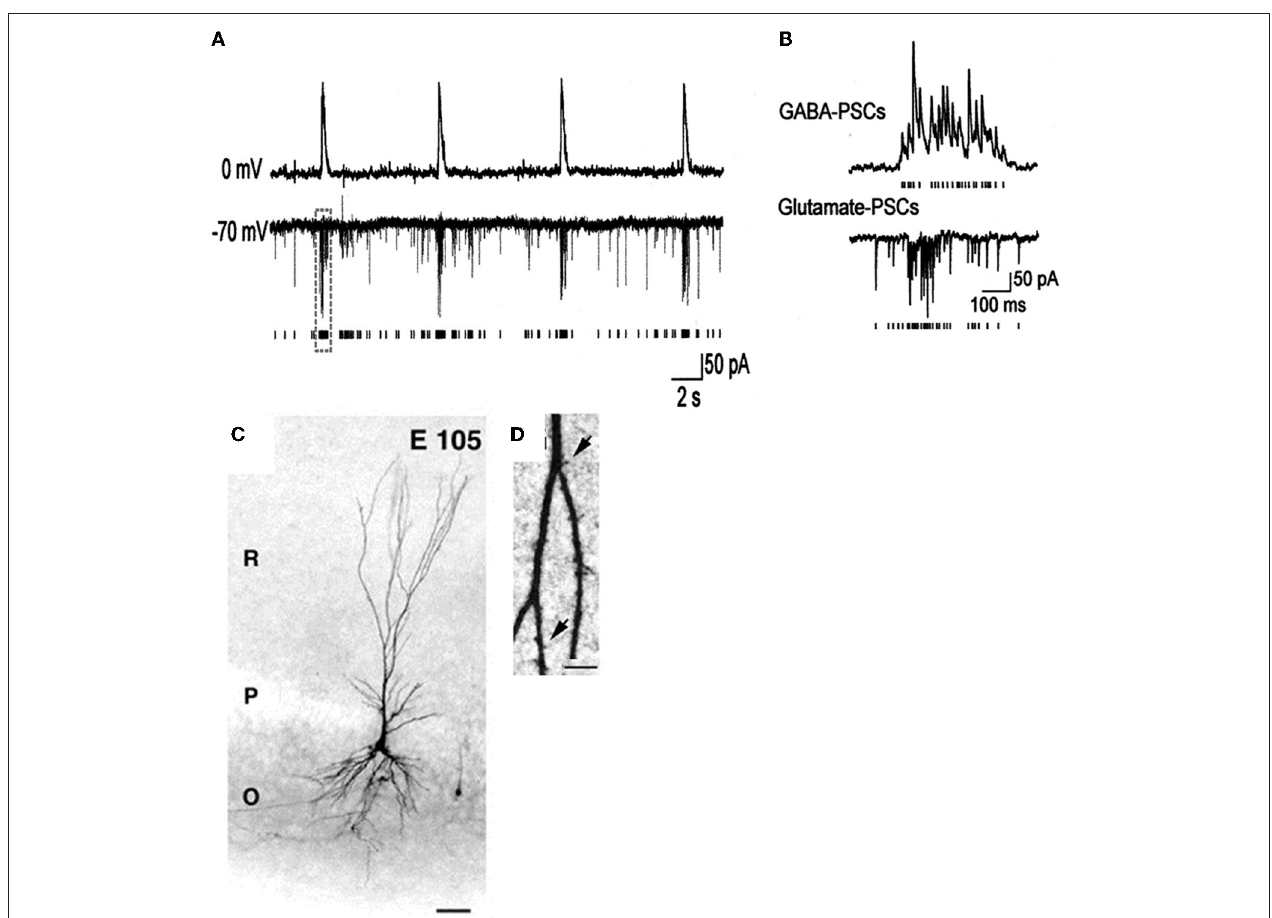
FIGURE 4 | Giant depolarizing potentials synchronize most of the Primate hippocampal neuronal activity in utero . (A,B) Pair recordings of CA3 pyramidal cells and interneurons (E109). (A) The pyramidal cell (top trace) is recorded in whole-cell mode at 0mV, and the interneuron (bottom trace) is recorded in whole-cell mode at the reversal potential of the GABA(A) PSCs ( − 70mV) so that the AMPA PSCs are inwardly directed. Each AMPA